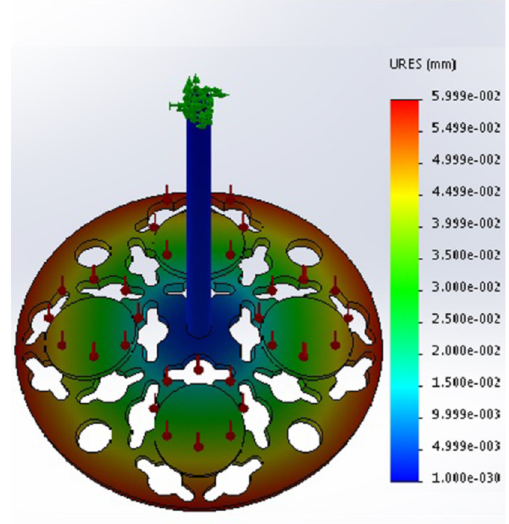
Fig. 13. The maximum deformation for the 4-Position Mass